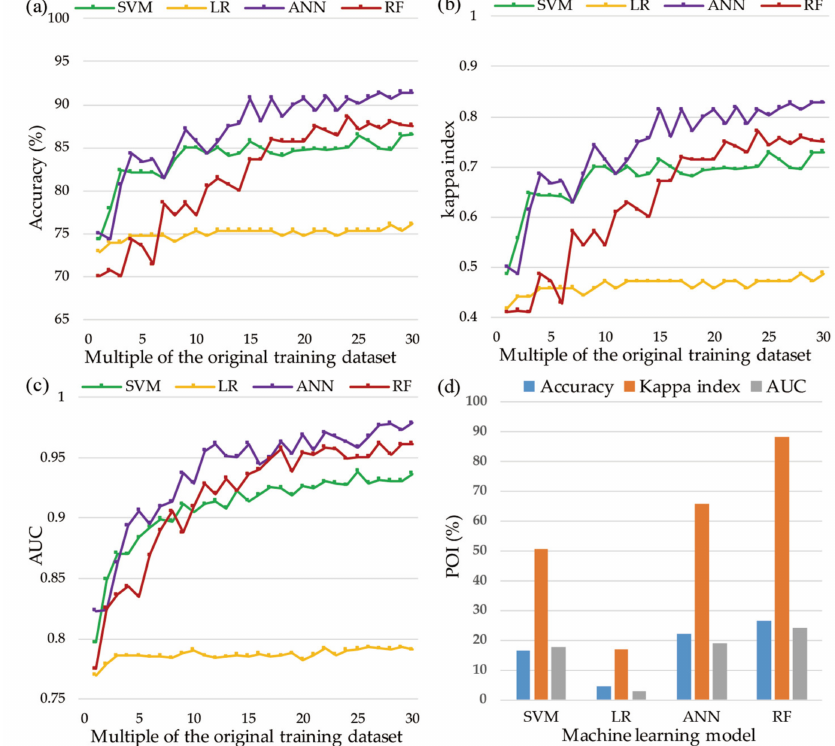
Figure 10. Predictive performances: ( a ) accuracy of each model with different training datasets; ( b ) kappa index of each model with different training datasets; ( c ) AUC of each model with different training datasets; and ( d ) POI of each model between the first and 30th training